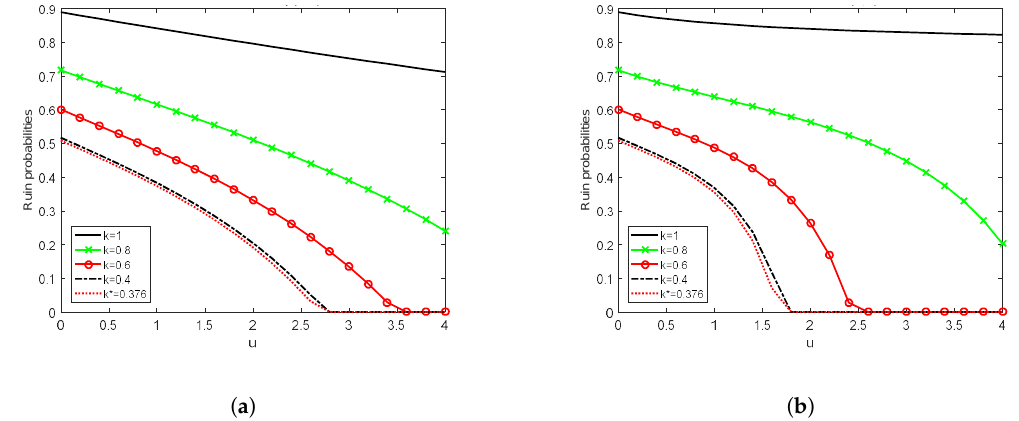
Figure 1. Ultimate ruin probabilities for the Cramér–Lundberg Model (CLM) compounded by proportional reinsurance; ( a ) CLM with quota-share (QS) reinsurance, Exp(0.5) claims; ( b ) CLM with QS reinsurance, Par(3,2)